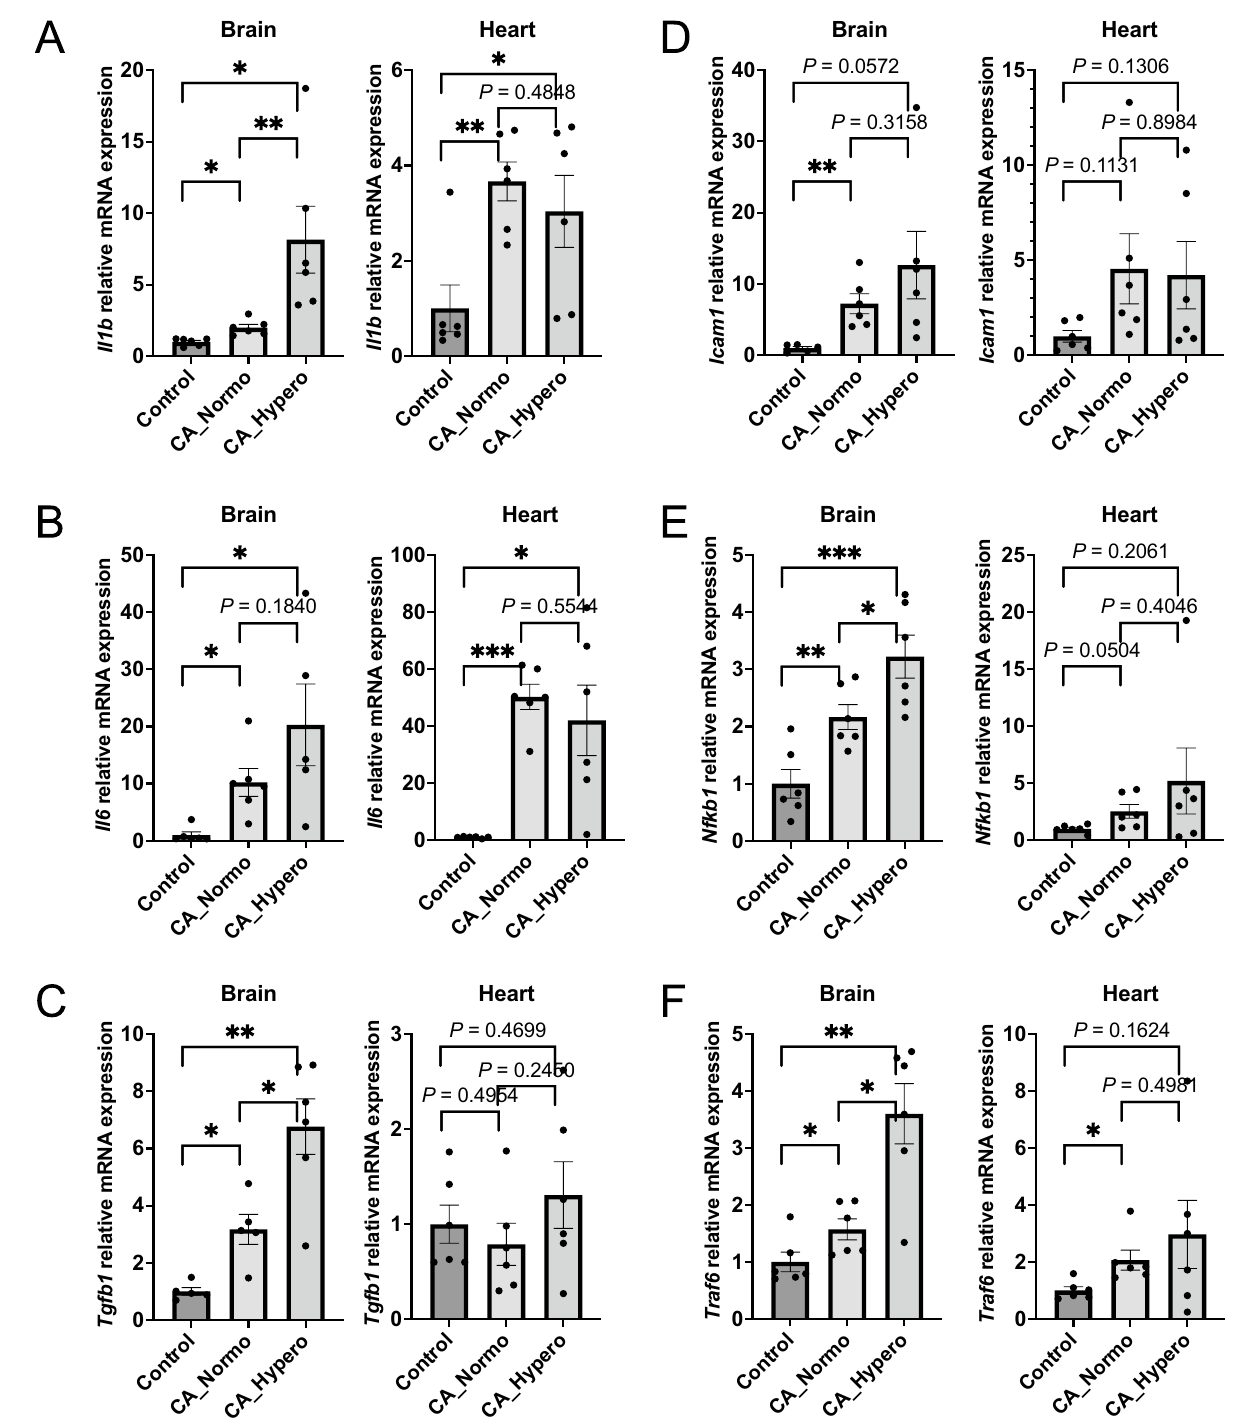
Figure 5. Inflammatory mRNA relative gene expressions. Il1b, Il6, Tgfb1, Icam1, Nfkb1 , Traf6 . Real time PCR was performed to compare mRNA gene expression. ( A ) Il1b was upregulated after CA in brain, which was significantly attenuated by normoxic therapy, whereas Il1b was not attenuated by normoxic therapy in heart. ( B ) Il6 was upregulated after CA, though there was no significant difference between CA_Normo group and CA_Hypero group in brain. Il6 also increased after CA, which was not attenuated by normoxic therapy in heart. ( C ) Tgfb1 was upregulated in CA_Hypero group in brain, which was significantly attenuated by normoxic therapy. Tgfb1 was not upregulated after CA in heart. ( D ) Icam1 was upregulated after CA, though there was no significant difference between CA_Normo group and CA_Hypero group in brain. Icam1 also tended to increase after CA, which was not attenuated by